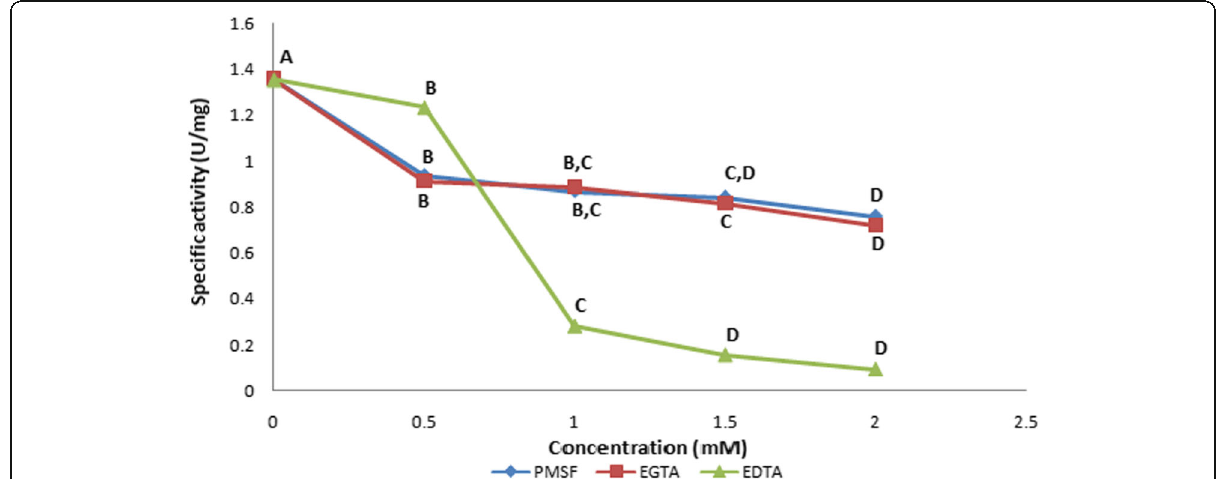
Fig. 8 Effect of PMSF, EGTA and EDTA on purified lipase from larval fat body tissue of G. mellonella . All experiments were carried out at 37 °C. PNPB (50 mM) was used as substrate. The enzyme reaction was incubated with various concentrations of inhibitor separately for 10 min. Different letters indicate significant differences ( p < 0.05), (no. of replicates =